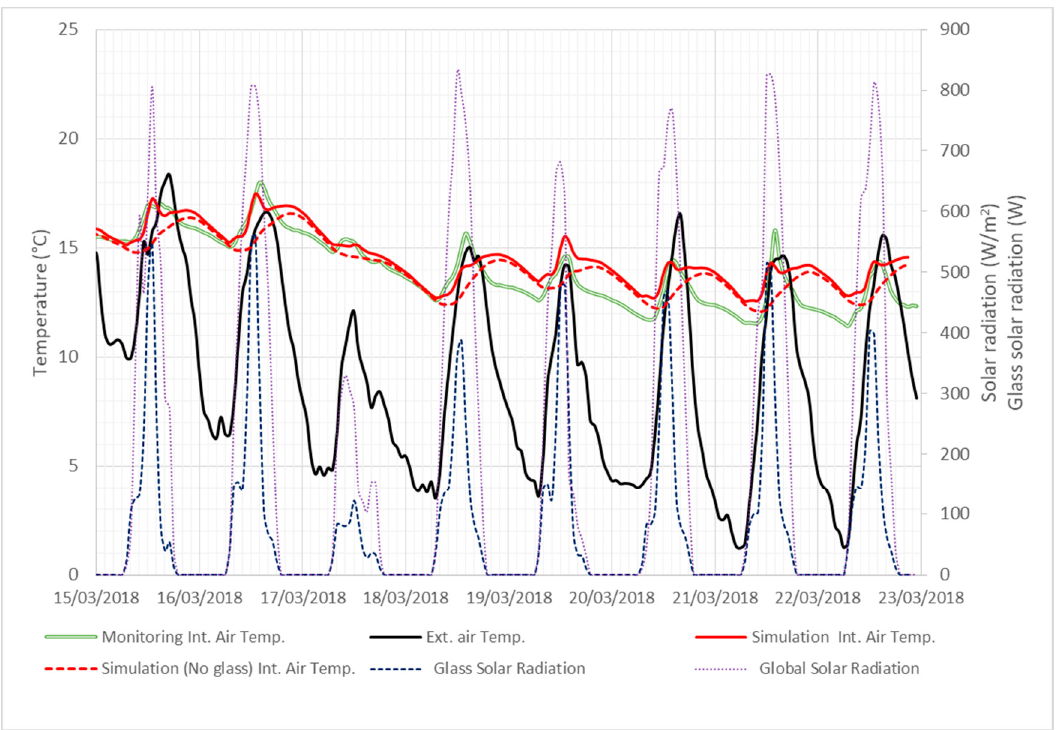
Figure 7. Interior simulated and monitored temperature, exterior temperature, solar radiation and radiation through the glazed surface, during the equinox.